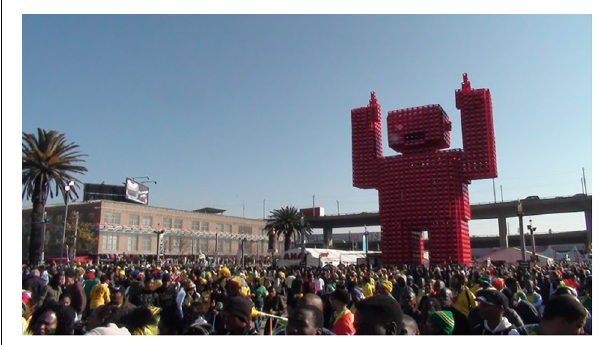
FIGURE 5 | Crowd and sculpture at Fan Fest in downtown Johannesburg.